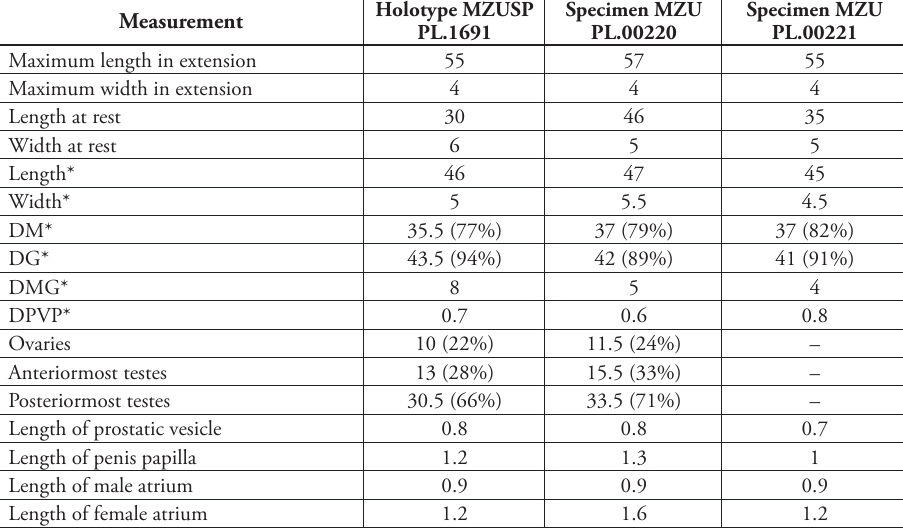
Table 3. Measurements, in mm, of specimens of Cratera nigrimarginata sp. n. Abbreviations: – not measured; * after fixation; DG distance of gonopore from anterior end; DM distance of mouth from anterior end; DMG distance between mouth and gonopore; DPVP distance between prostatic vesicle and pharyngeal pouch. The numbers given in parentheses represent the position relative to body length. Holotype MZUSP Specimen MZU Specimen MZU Measurement PL.1691 PL.00220 PL.00221 55 57